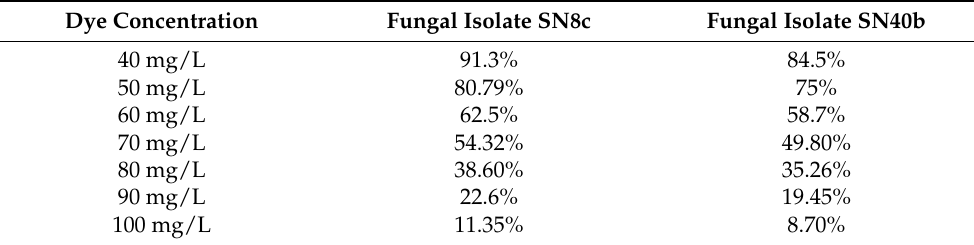
Table 1. Effect of RBB dye concentration on decolorization.